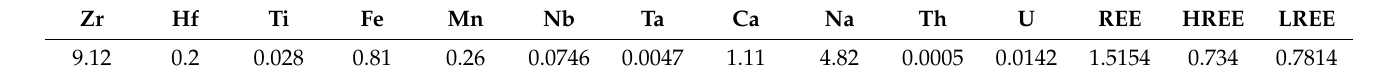
Table 5. Common value components of the Zr-REE bearing concentrate (in wt.%).